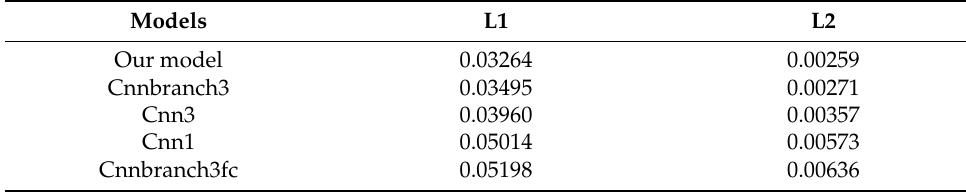
Table 4. Comparison results for Yan’an elevated highway.